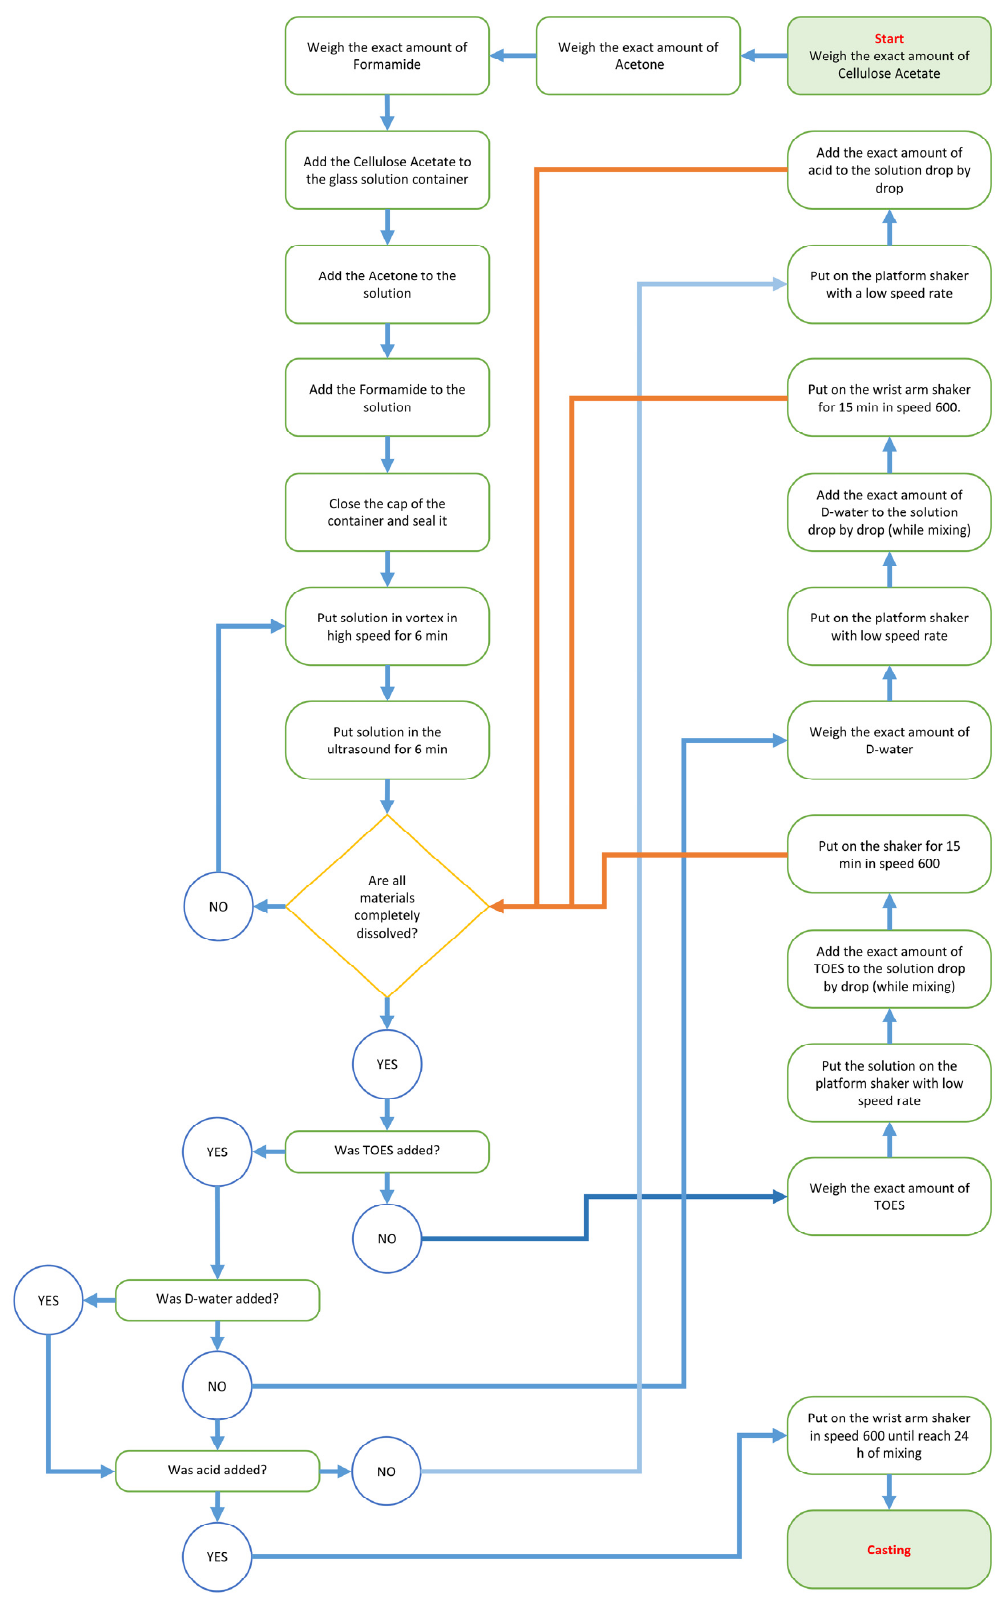
Figure 3. Flowchart of hybrid membranes preparation.